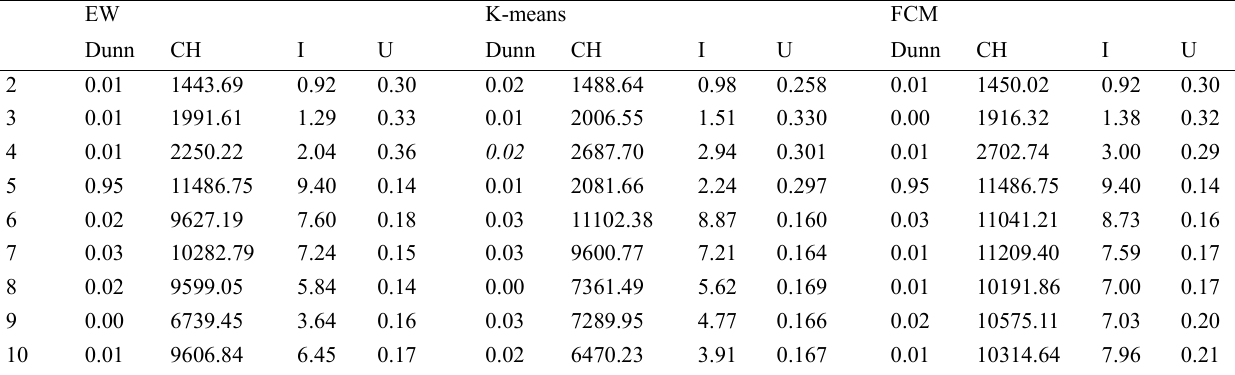
Table 2. Effectiveness evaluation of simulated data under three discretization algorithms